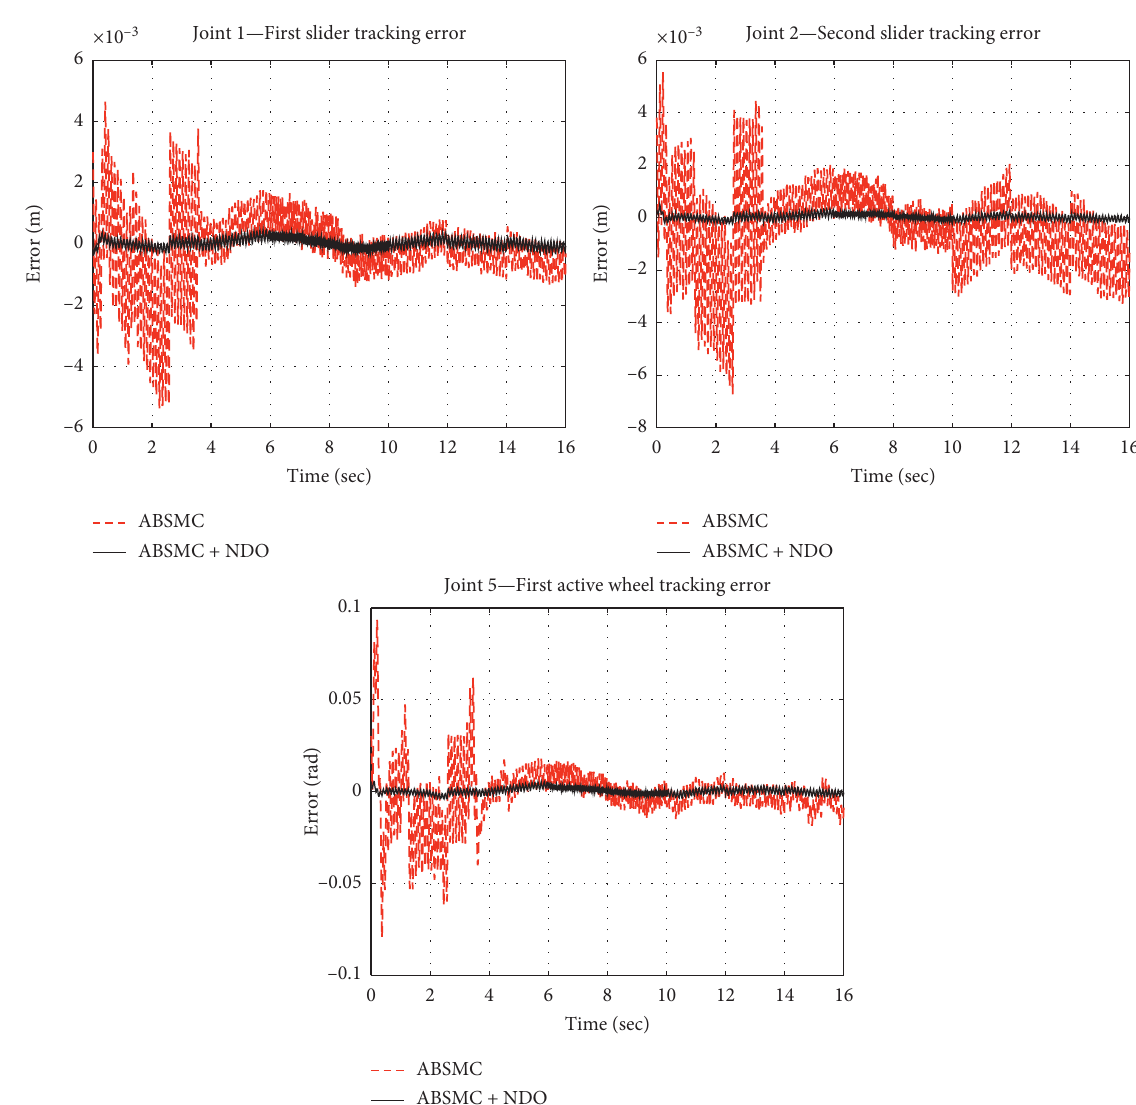
Figure 9: The experimental results of each